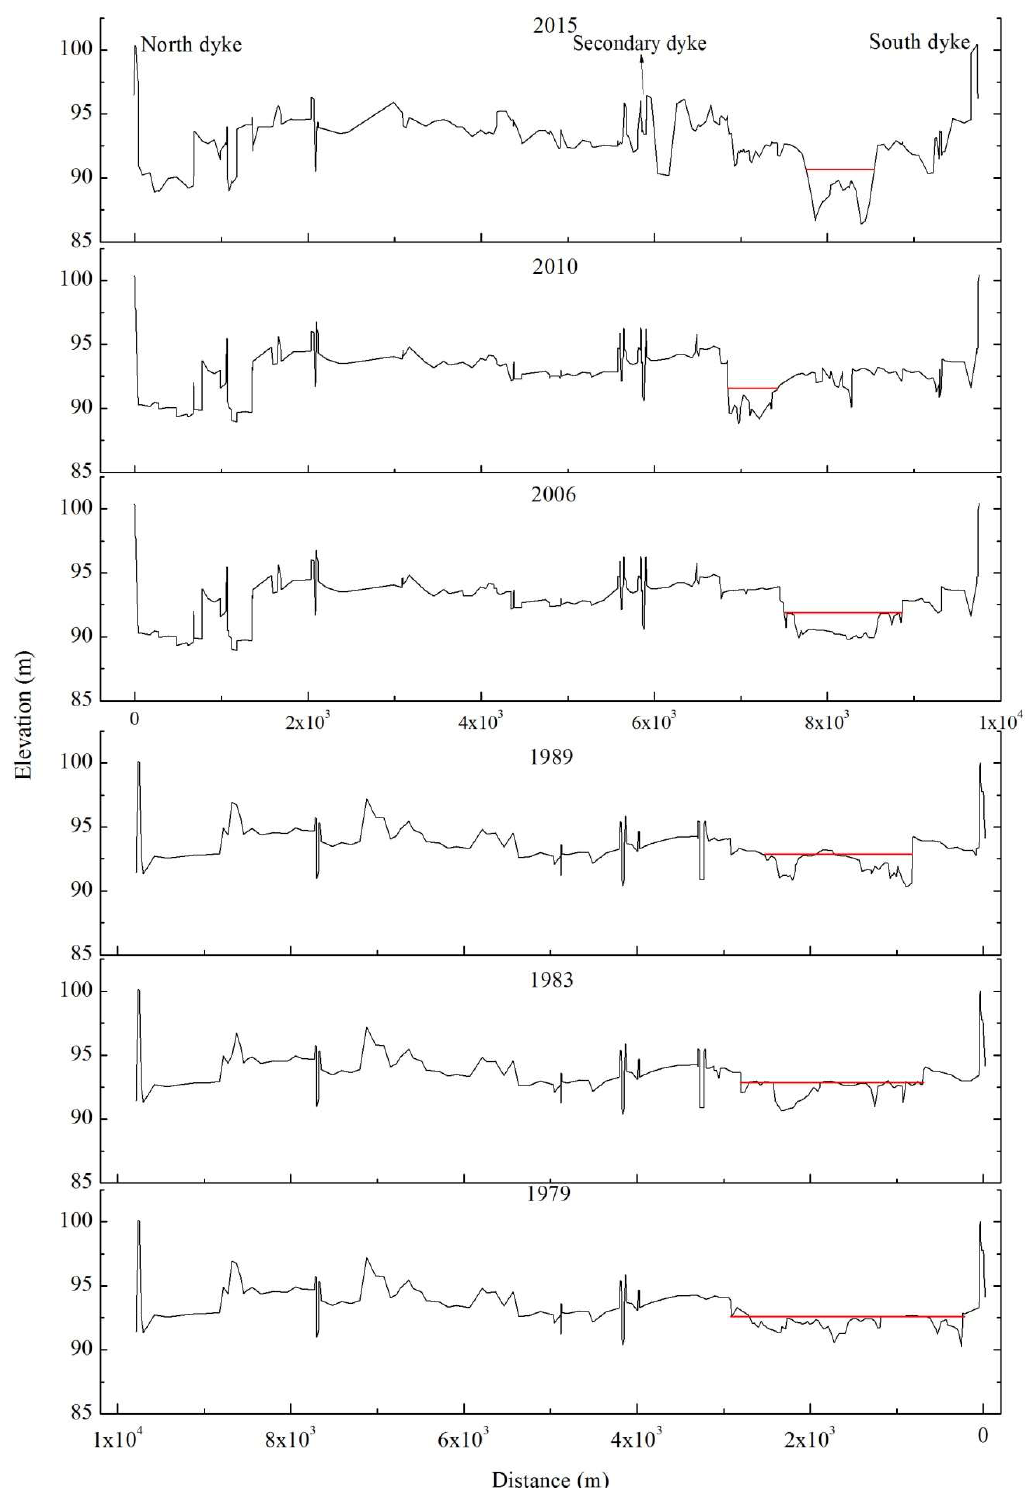
Figure 2. The transverse cross-profiles of the Yellow River near the Huayuankou gauging station (including floodplains and river channel) measured from the south dyke to the north dyke in the pre-flood seasons of 1979, 1983, and 1989 along with from the north dyke to the south dyke in the pre-flood seasons of 2006, 2010, and 2015, respectively. Data source: Hydrological Yearbooks of P. R. China (1979, 1983, 1989, 2006, 2010, 2015 for the Huanghe River (Yellow River) Drainage Basin).